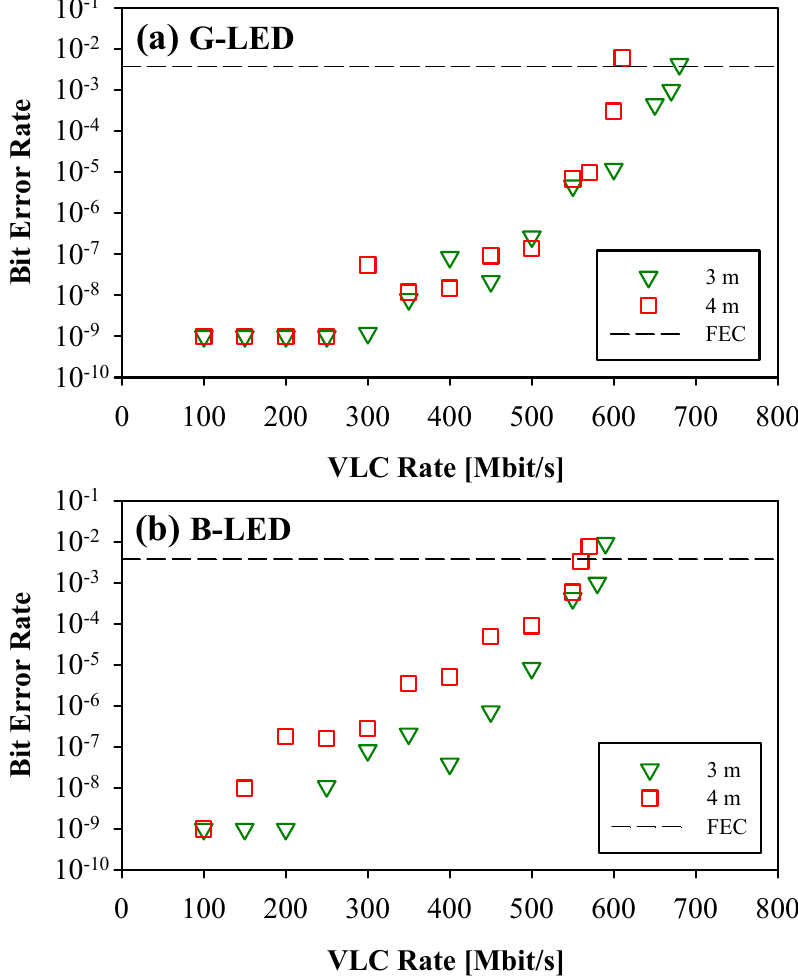
Figure 3. Different measured VLC rates of ( a ) G − and ( b ) B − LEDs versus the corresponding BER after 3 and 4 m free space transmissions under WDM VLC connection, respectively.